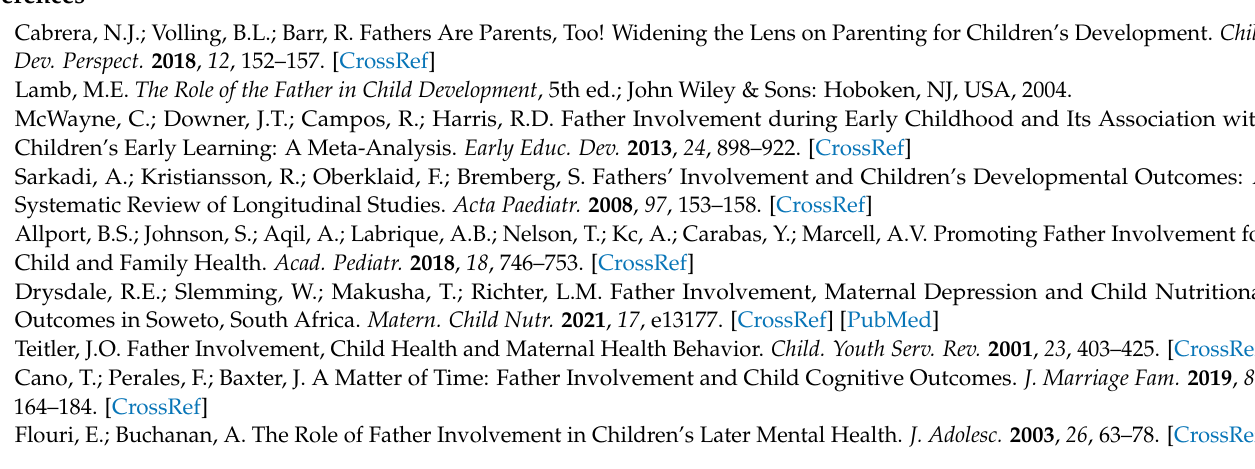
outcomes, Table S2: Effects of the covariates on the distal outcomes, Syntax S1: Mplus